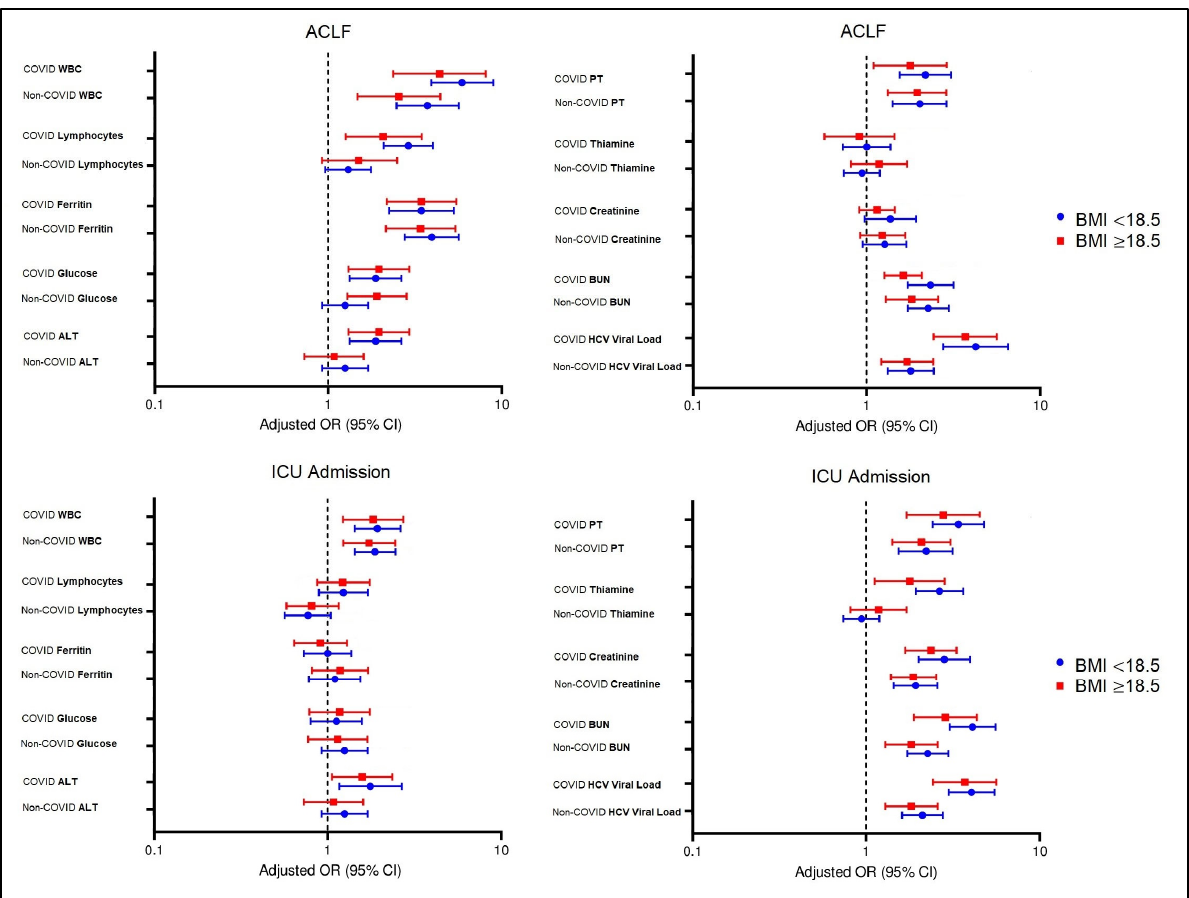
Figure 1. The association of laboratory parameters with ACLF and ICU admission in underweight and normal weighted patients with cirrhosis from the two study groups.